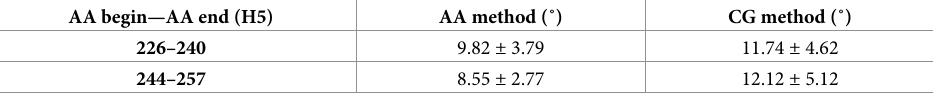
The tilt angle are obtained from the 1 μ s AA MD run at P = 1.01325 bar and T = 310 K and the 5 μ s CG MD runs at P = 1.01325 bar and T = 310 K.